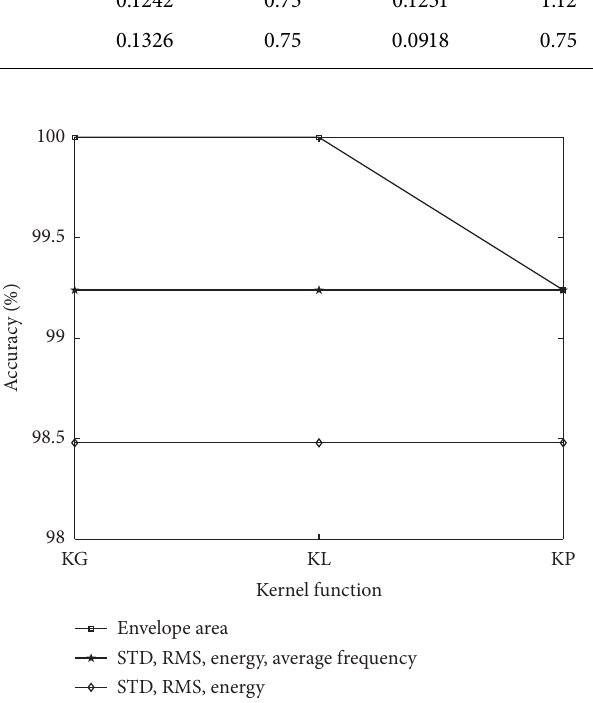
Figure 5: The results after running the test for envelope area and feature sets.